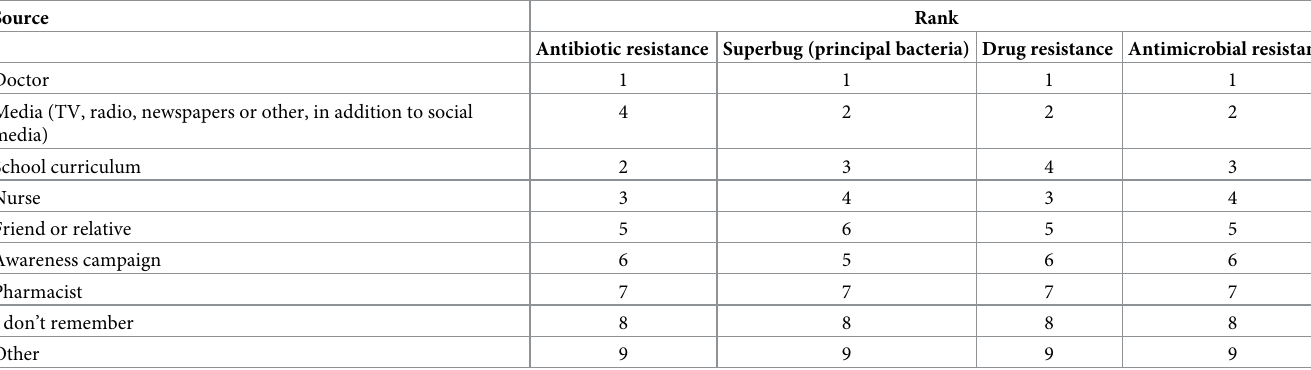
Table 7. Sources of information associated with antibiotic (Survey Qs